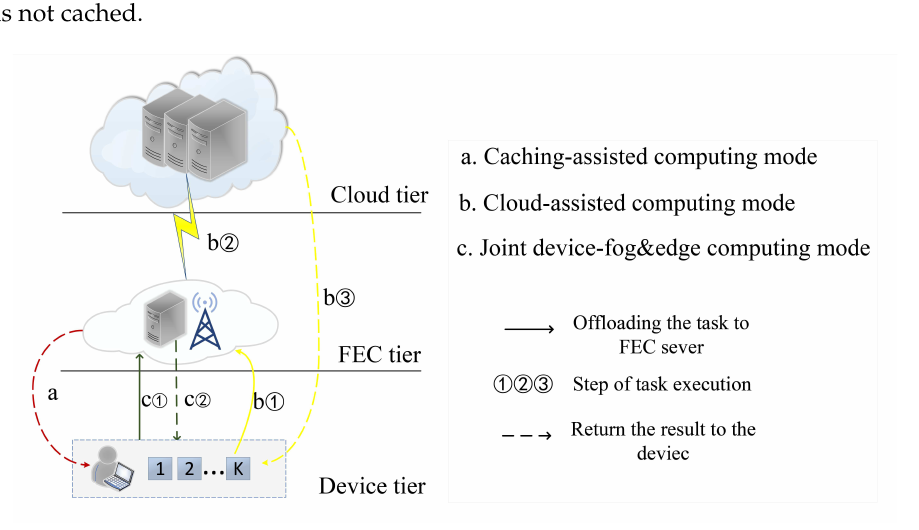
Figure 1. Illustration of the hierarchical cloud-fog&edge computing network.